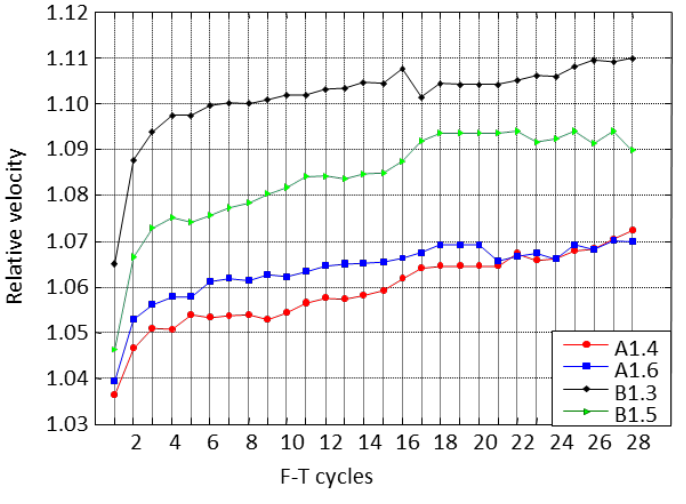
Figure 17. Relative velocity of specimens at the plateau of the